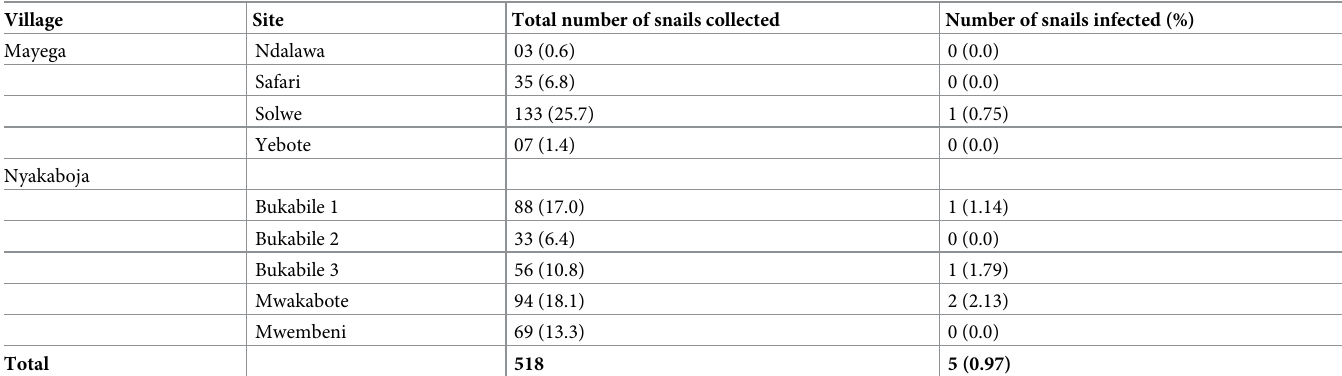
Table 6. Prevalence of Biomphalaria sudanica cercariae shedding per site.